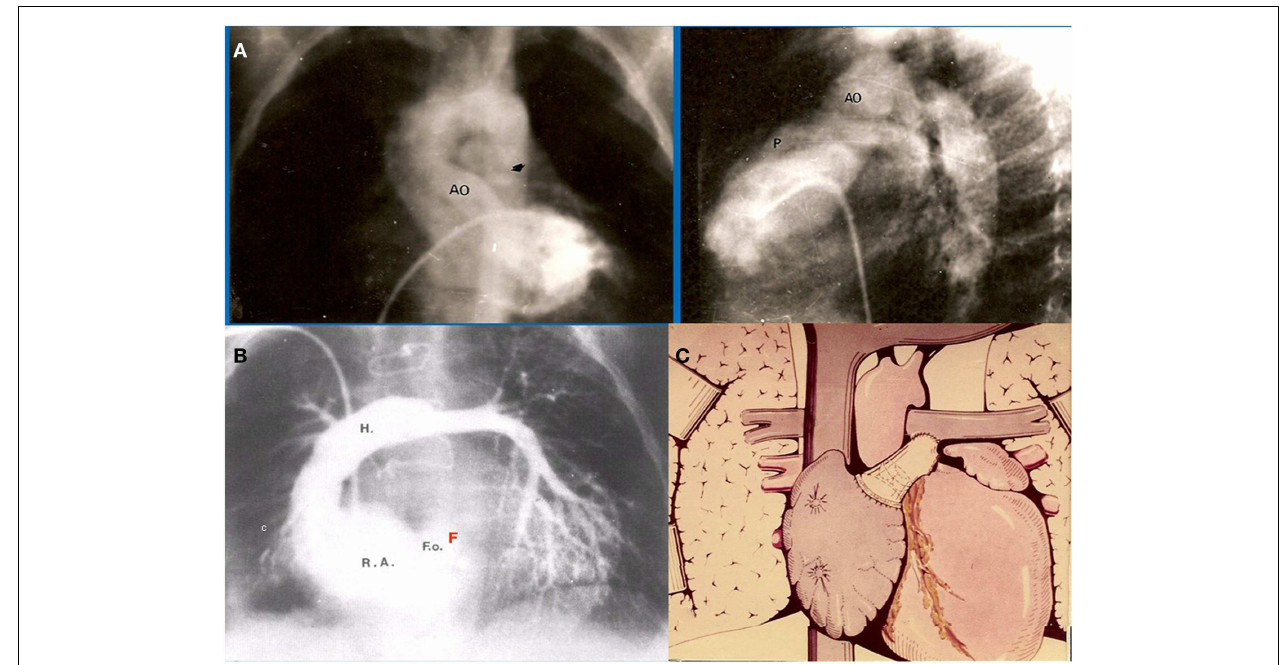
interposition of a homograft. Note there is a small atrial communication left open, acting as a fenestration (F). (C) Schematic representation of the original APA performed in this patient, communicated in J.Thorac. Cardiovasc.